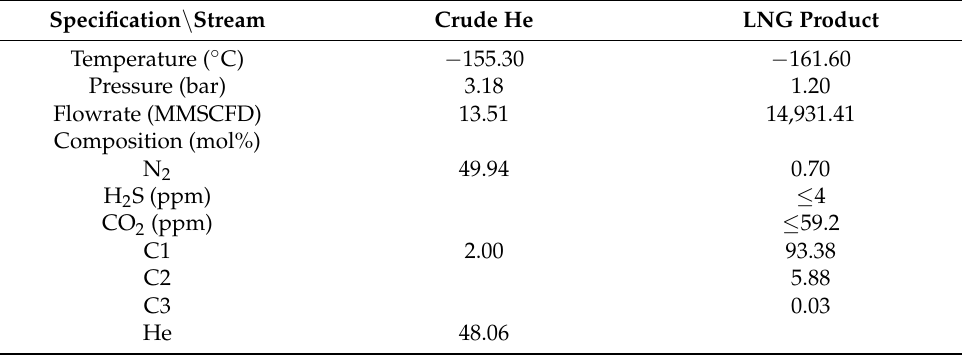
Table 9. HeX and NR unit conditions and